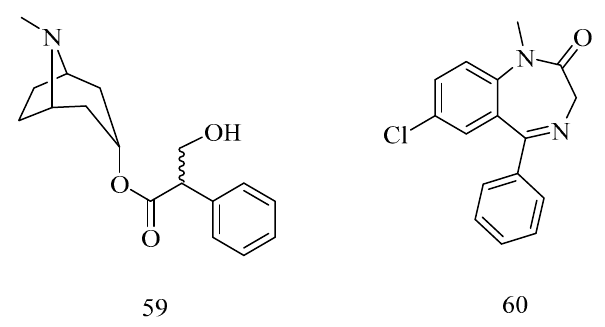
Figure 15. Atropine and diazepam.